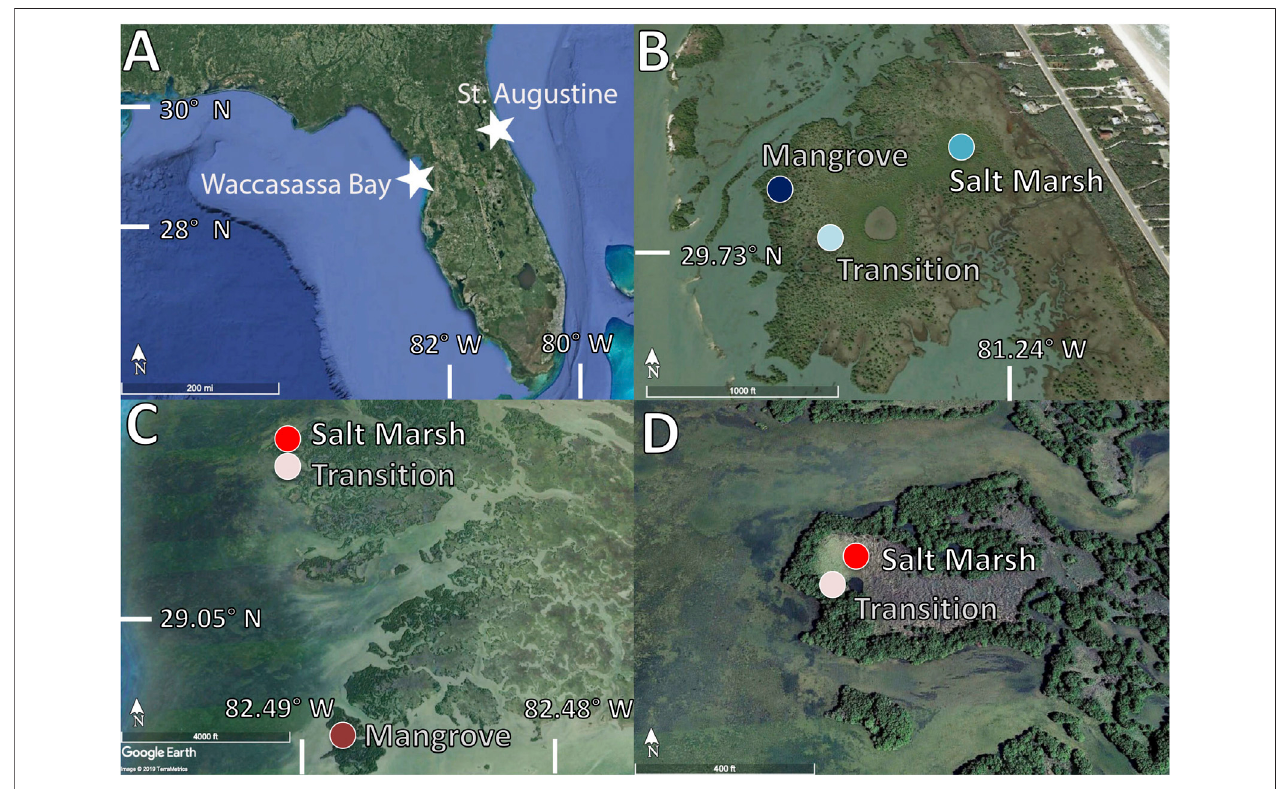
FIGURE1|(A) MapofFlorida(GoogleEarth,2019)showingthetwonortherncoastalwetlandsites (B) VibracorelocationsinSt.Augustine(GoogleEarth,2019)in a mangrove vegetation zone (dark blue) , a salt marsh vegetation zone (medium blue) and a transition zone (light blue) (C) Vibracore locations in Waccasassa Bay (Google Earth, 2019) in a mangrove vegetation zone (dark red) , a salt marsh vegetation zone (medium red) and a transition zone (light red) (D) A zoom in on the saltmarsh (medium red) and transition (light red) locations in Waccasassa Bay (Google Earth, 2019).